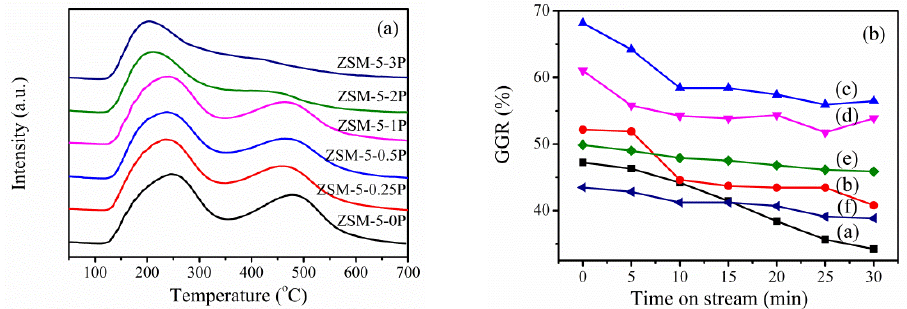
Figure 19. NH 3 -TPD profiles ( a ); and GGR variation of n -dodecane cracking ( b ) over phosphorus-modified ZSM-5 zeolites for 30 min at 550 °C under the pressure of 4 MPa: ( a ) ZSM-5-0 P; ( b ) ZSM-5-0.25 P; ( c ) ZSM-5-0.5 P; ( d ) ZSM-5-1 P; ( e ) ZSM-5-2 P; and ( f ) ZSM-5-3 P [118]. Copyright